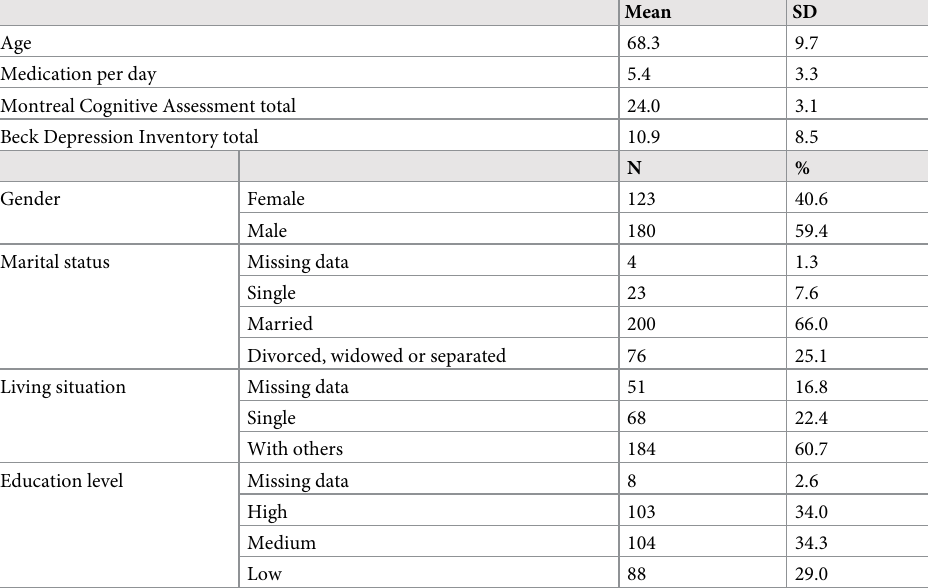
Table 1. Clinical and epidemiological characteristics.